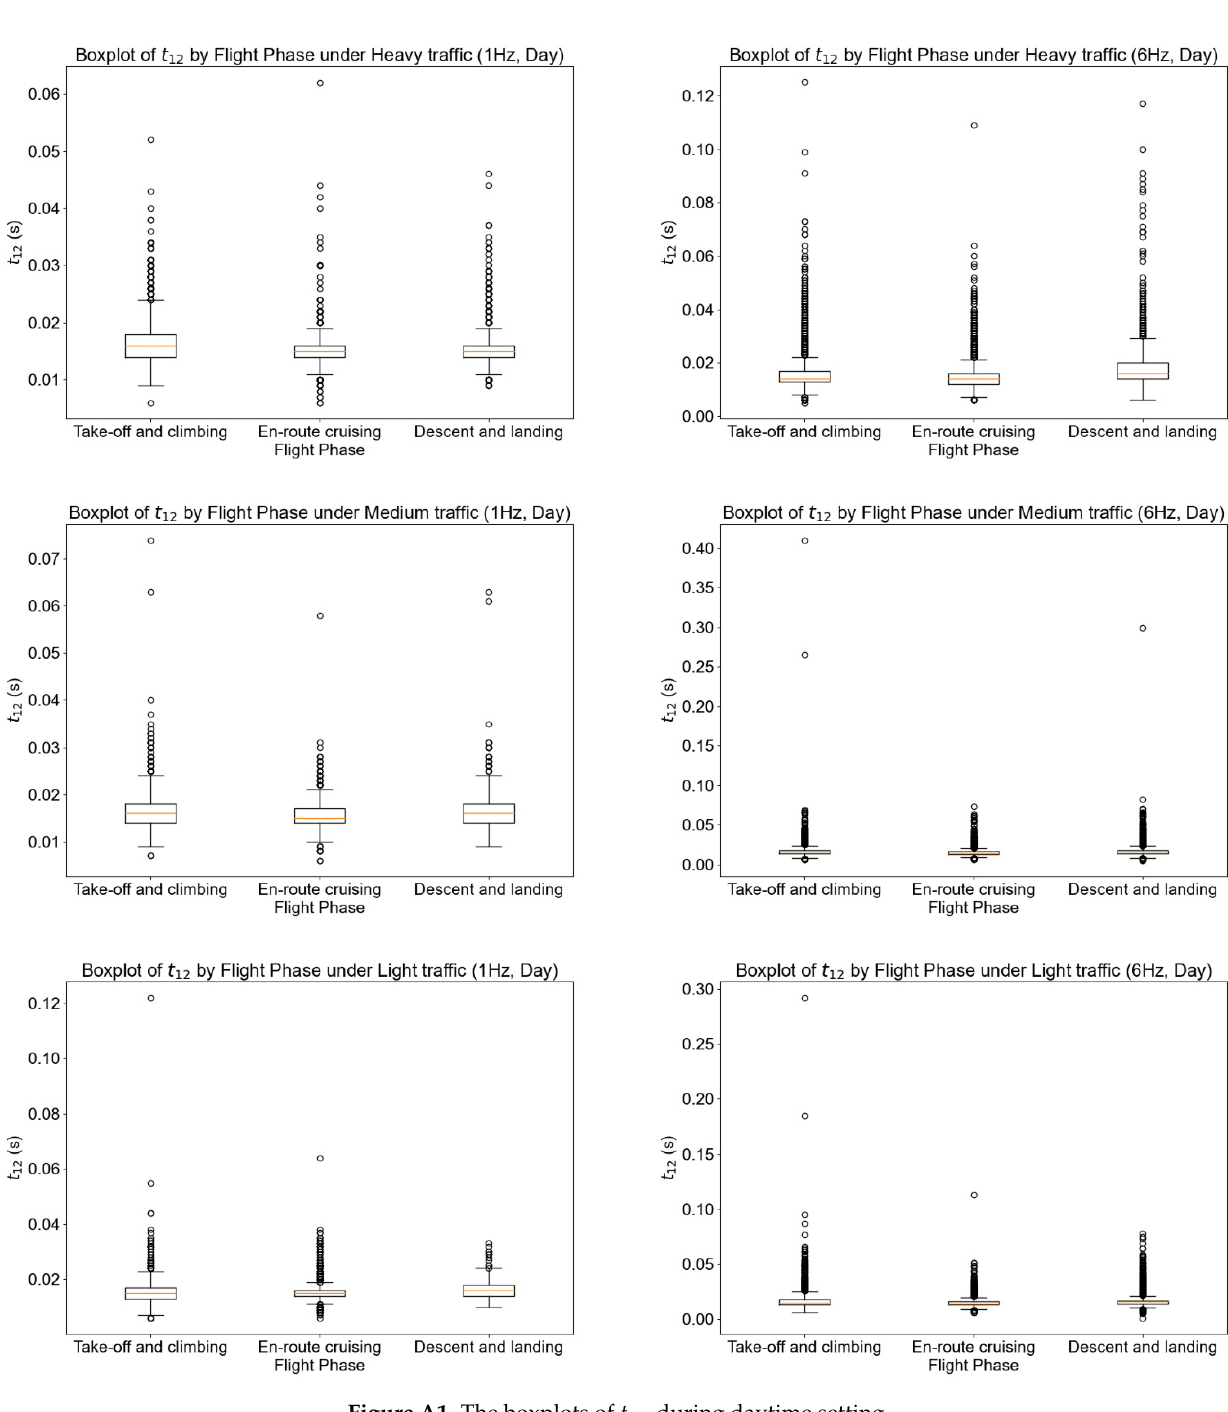
Figure A1. The boxplots of 𝑡 (cid:2869),(cid:2870) during daytime setting.